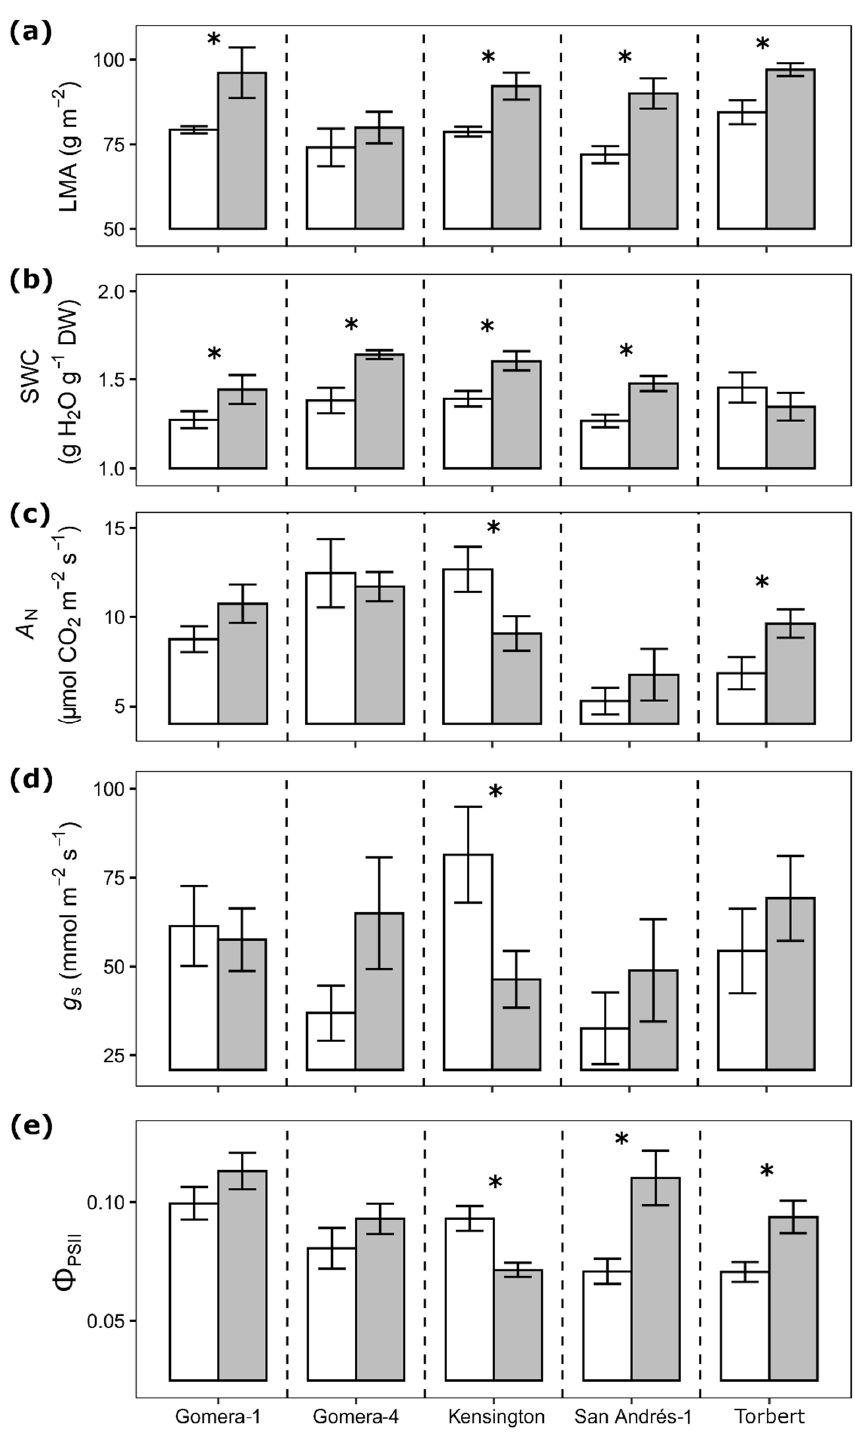
Figure 2. Effect of ploidy on leaf morphological and physiological traits on two-year-old mango trees under well-watered conditions (averaged data for all days for plants that were regularly watered to field capacity, n = 10–40). ( a ) Leaf mass area (LMA), ( b ) saturated water content (SWC), ( c ) net CO 2 assimilation rate ( A N ) under light-saturating conditions (1200 μ mol m − 2 s −− 1 ), ( d ) stomatal conductance to CO 2 ( g s ), and ( e ) light-adapted quantum biochemical yield of photosystem II ( Φ PSII ) are shown for the five studied diploids (white) and tetraploids (grey) cultivars. Asterisks represent significant differences between tetraploids and diploids ( t -test; p <